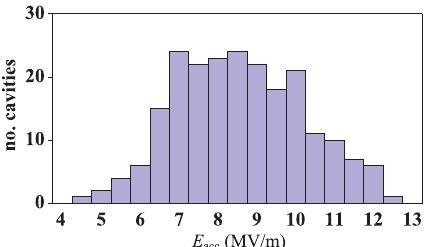
FIG. 14. Matched rf load at full beam current (from [85]).